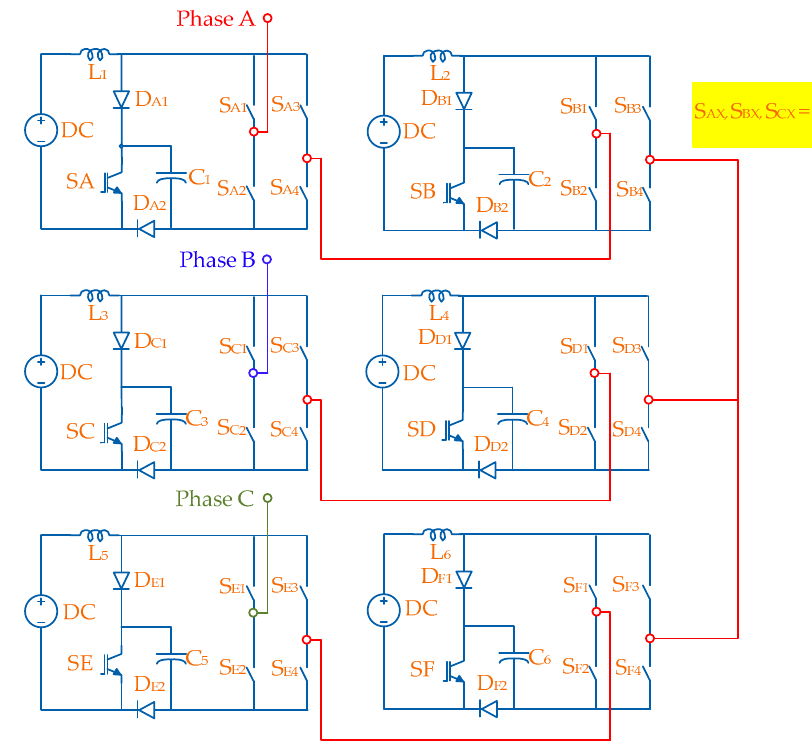
Figure 27. Three-phase cascaded H-bridge qSBI topology.